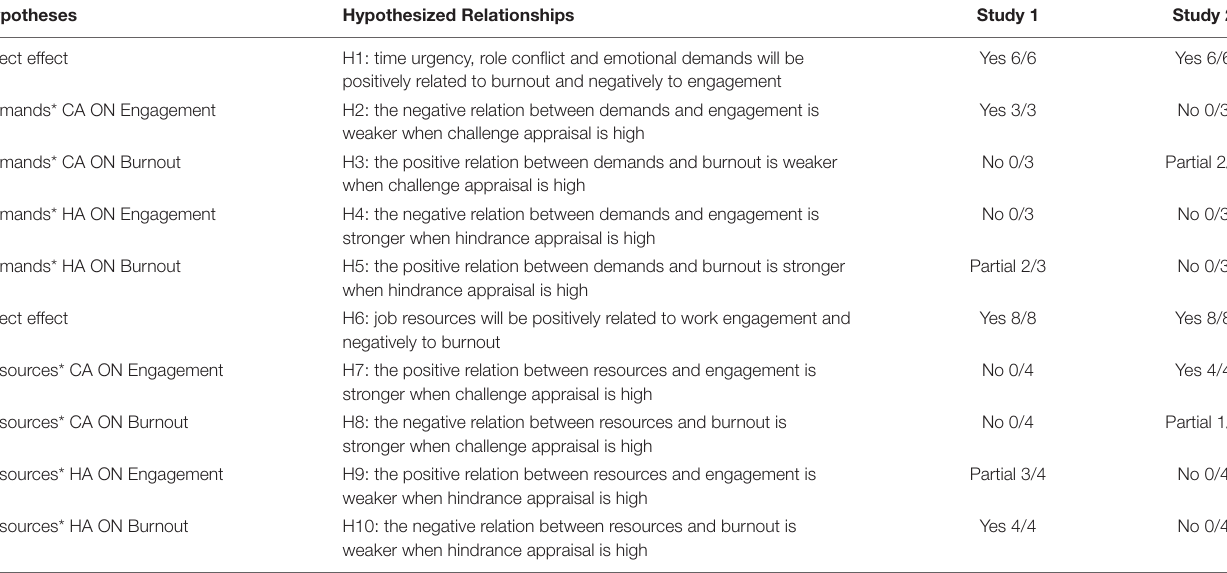
TABLE 9 | A comparison of the interaction effect between job characteristics and appraisals among two studies. Hypotheses Hypothesized